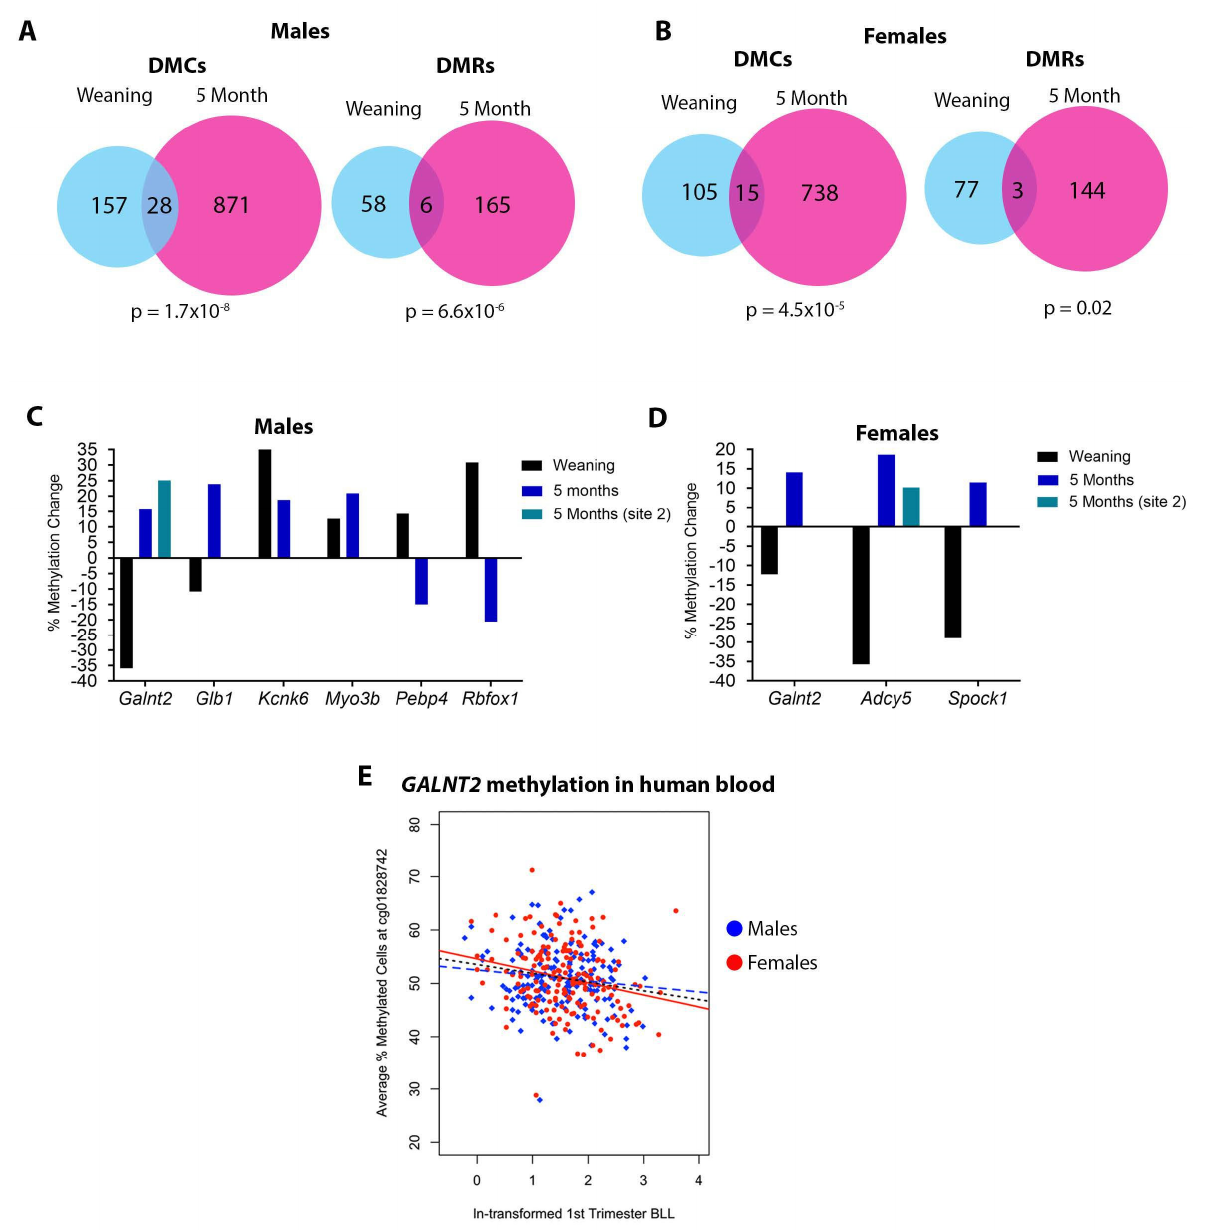
Figure 6. Comparison of Pb-induced DNA methylation changes between weaning and 5 months of age. ( A , B ) Venn diagrams depicting overlap in DMC- and DMR-associated genes between cohorts sacrificed at weaning and 5 months of age in males ( A ) and females ( B ). ( C , D ) bar plots depicting the direction of methylation change in DMRs, comparing the weaning and 5-month cohorts. Galnt2 and Adcy5 had 2 DMRs at 5 months of age. ( E ) First-trimester blood Pb levels (BLL) vs. GALNT2 methylation in adolescent blood leukocyte DNA. One CpG site annotated to an intron of GALNT2 was statistically significantly associated with Pb when adjusting for gender, batch, and blood cell composition ( p = 0.00009). Red points and line: Female subjects and regression line. Blue points and line: Male subjects and regression line. Black line: Regression line for both sexes